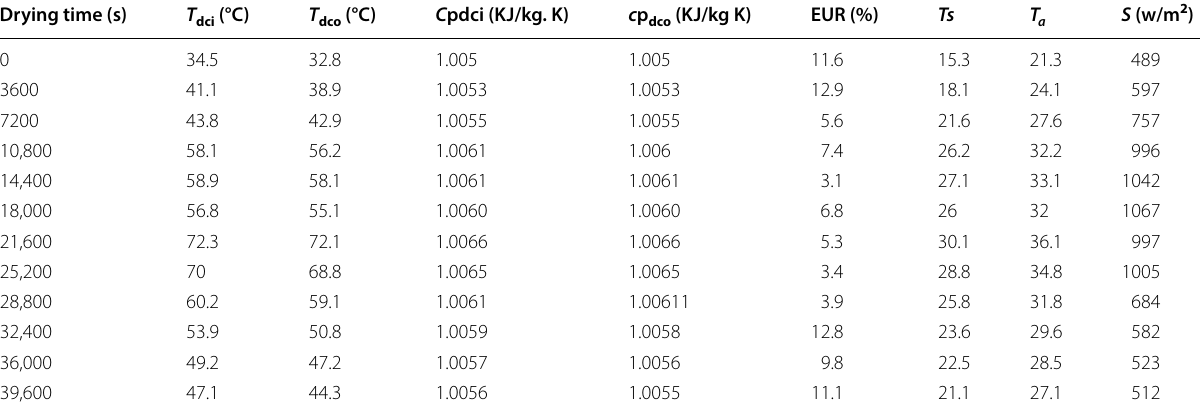
Table 15 Result energy analysis tomato 3rd day